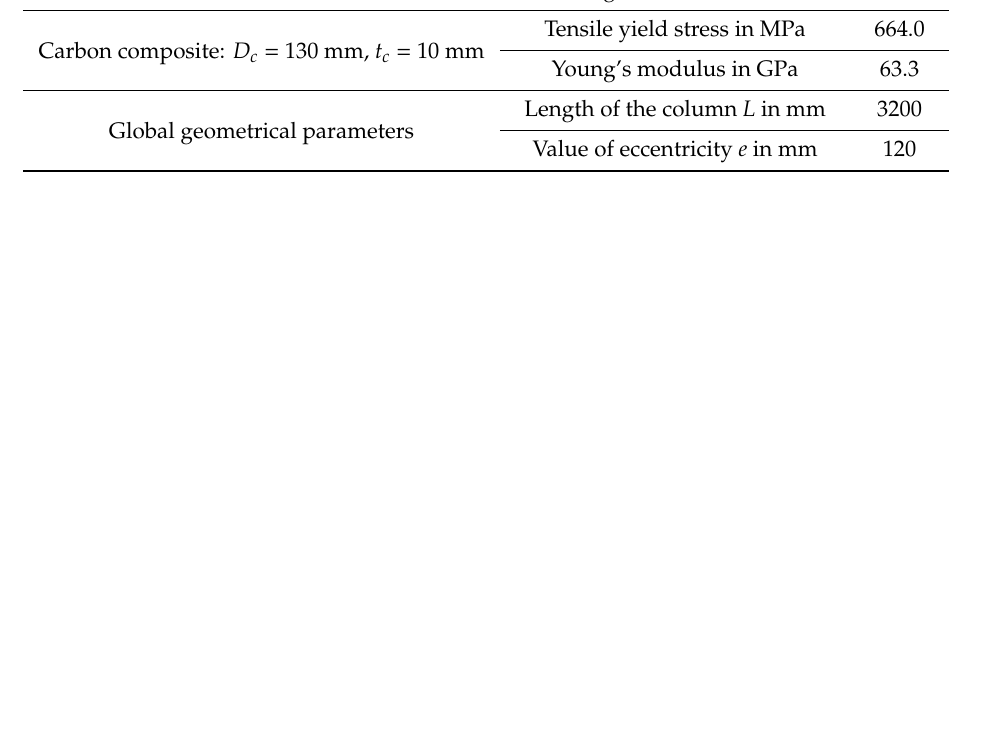
Figure 2. The beam column geometrical and mechanical data: ( a ) Tubular cross section; ( b ) adopted, simplified characteristics for cast iron ; ( c ) loading scheme.